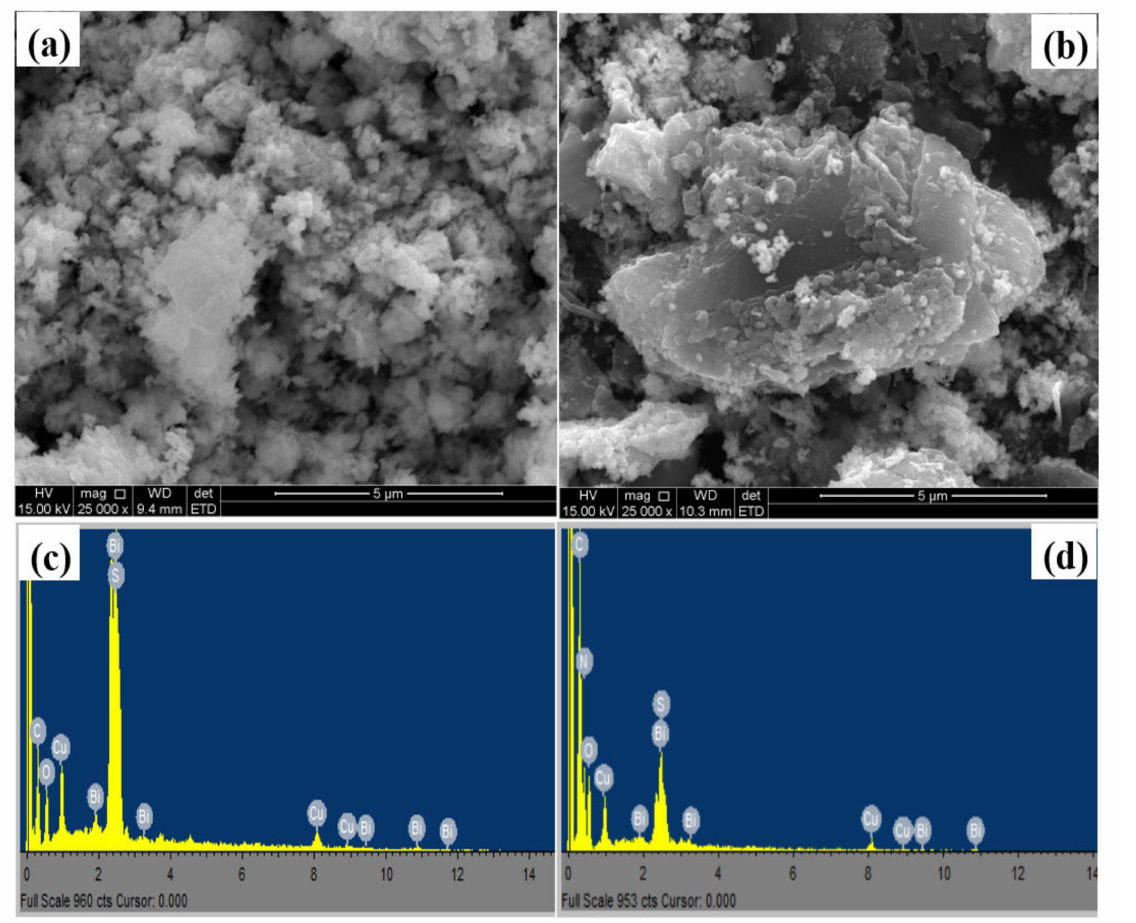
Figure 3. SEM images of ( a ) Cu 3 .2 1 Bi 4.79 S 9 , ( b ) Cu 3.21 Bi 4.79 S 9 /gC 3 N 4 , and their respective ( c , d ) EDX